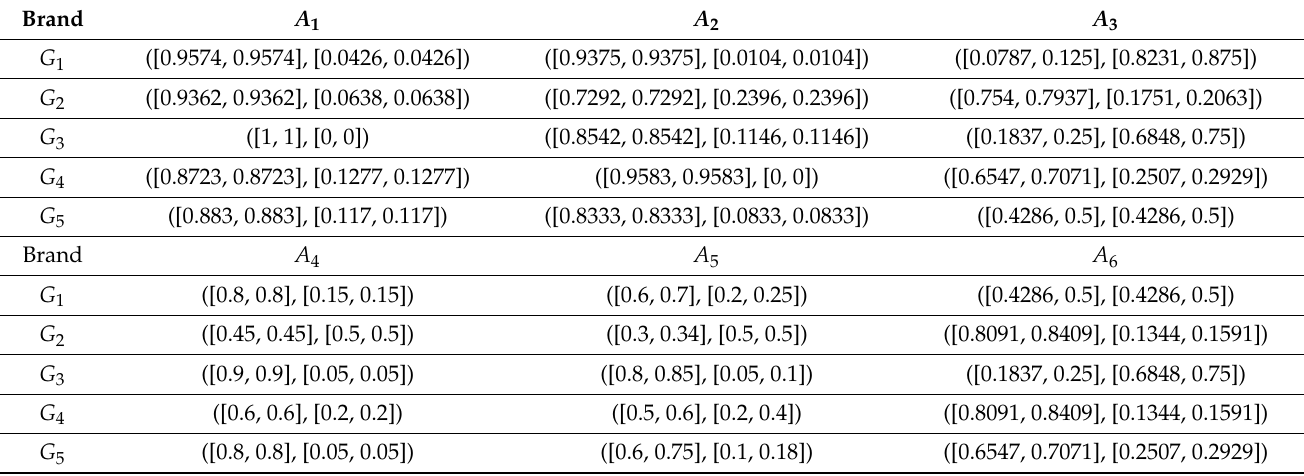
Table 7. The transformed evaluation matrix of expert D 1